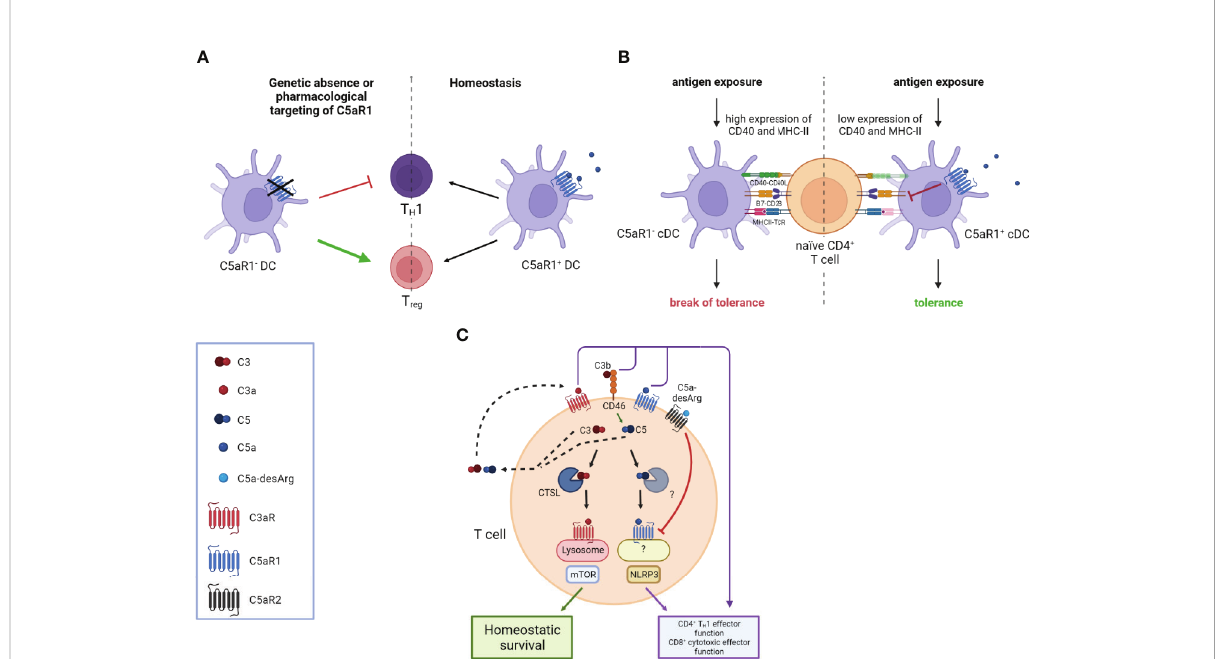
FIGURE 1 Impact of the anaphylatoxins on DC-mediated and intrinsic T cell activation. (A) The genetic absence or pharmacological targeting of C5aR1 on DCs leads to attenuated T helper type 1 (T H 1) immunity and an increased frequency of Regulatory T cells (Tregs). (B) C5aR1 signaling on naïve mucosal conventional DC2 (cDC2) controls the expression of CD40 and MHC-II which determines the threshold of naïve CD4 + T cell activation. Mucosal antigen exposure is associated with decreased C5aR1 expression; the lack of C5aR1 expression in cDC2s releases the break on CD40 and MHC-II expression resulting in strong CD4 + T cell proliferation and the break of mucosal tolerance. (C) T cell activation triggers the secretion of preformed C3 and C5 into the extracellular space, which can be cleaved into C3a, C3b, C5a, and C5b by canonical and non- canonical mechanisms. Binding of these complement fragments to their respective receptors on the T cell induces CD4 + T H 1 and CD8 + effector T cell functions. C3 and C5 are also processed intracellularly by proteases such as cathepsin L (CTSL) in the case of C3 and an unknown protease in the case of C5, respectively. Intracellular C3a is critical to maintain low-level mechanistic target of rapamycin (mTOR) activity by binding to C3aR on lysosomes, thereby contributing to the homeostatic survival of CD4 + T cells. The cleavage of intracellular C5 into C5a and C5b is enhanced by CD46-mediated signaling. C5a engages C5aR1 triggering NOD-like receptor family pyrin domain containing 3 (NLRP3) in fl ammasome assembly, eventually driving T H 1 differentiation of CD4 + T cells and CD8 + effector T cell functions. Importantly, autocrine engagement of surface-expressed C5aR2 by C5a-desArg can control intracellular C5aR1 activity. Created in